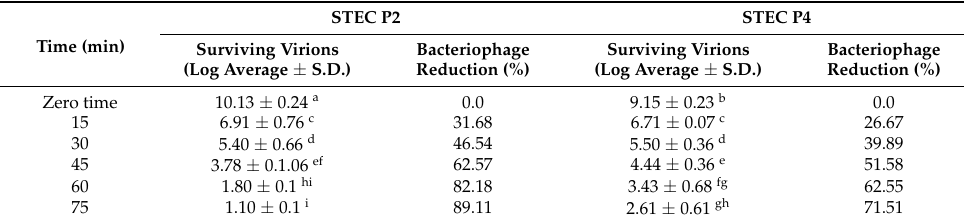
Table 3. UV stability of STEC P2 and STEC